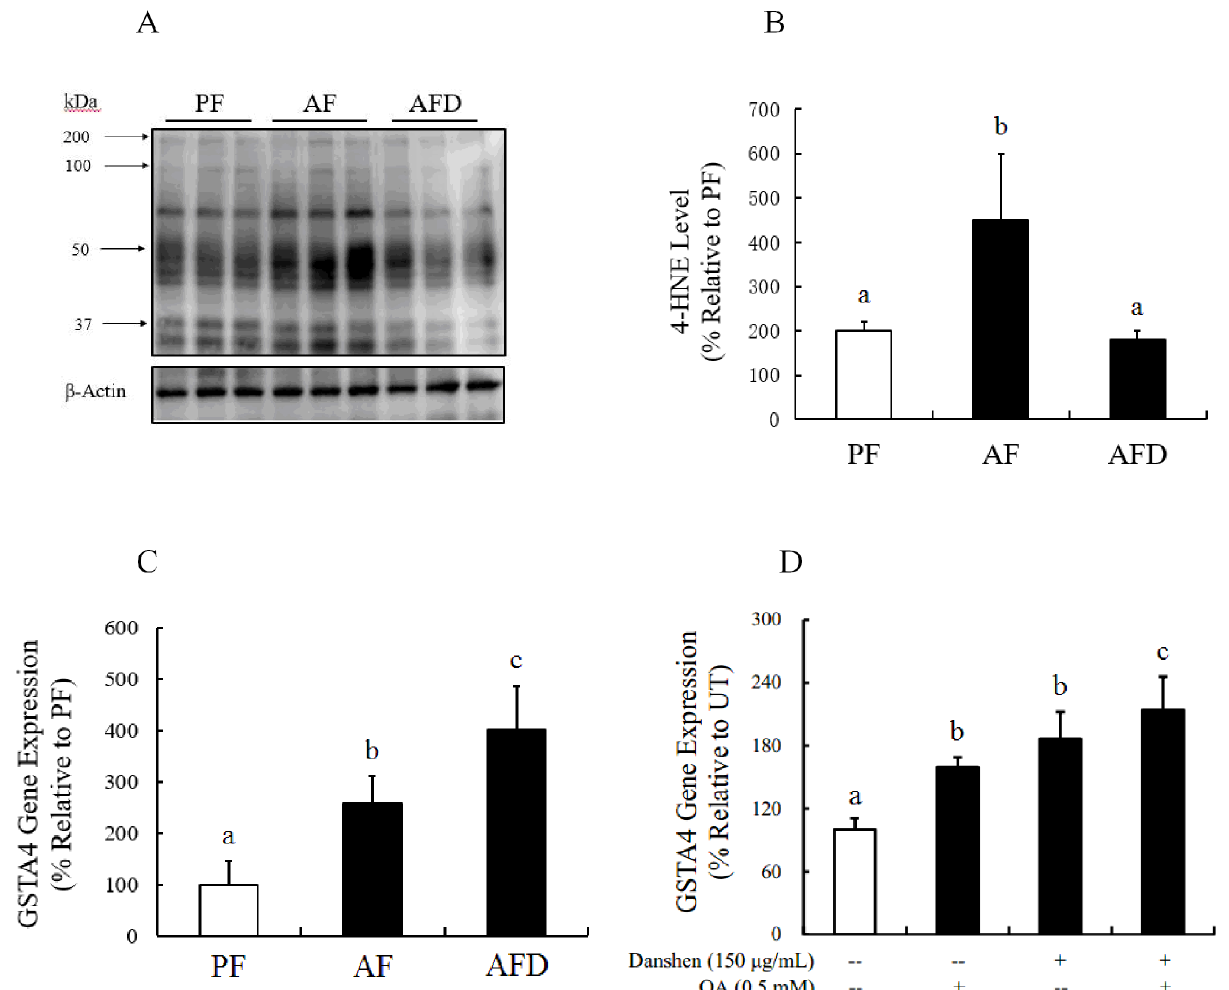
Fig 2. Danshen inhibits 4-HNE expression in mice fed an ethanol-containing Lieber-DeCarli diet. A . Protein expressionof 4-HNE in variousgroups of mice as indicatedby Western Blotting. B . The expressionof 4-HNE. C . Gene expressionlevel of GSTA4 in different groups of mice. Data are expressedas the mean ± SD (n = 8 mice per group). Bars with different letters differ significantly (p < 0.05). PF: pair feeding; AF: alcoholfeeding; AFD: alcoholfeedingwith Dansheninjection. D . Gene expressionlevel of GSTA4 in NCTC1469 cells treated with Danshenat 150 μ g/mL and/or Oleate (OA) at 0.5 mM. All values are denotedas the mean ± SD from three or more independent studies. Bars with different letters differ significantly (p < 0.05).